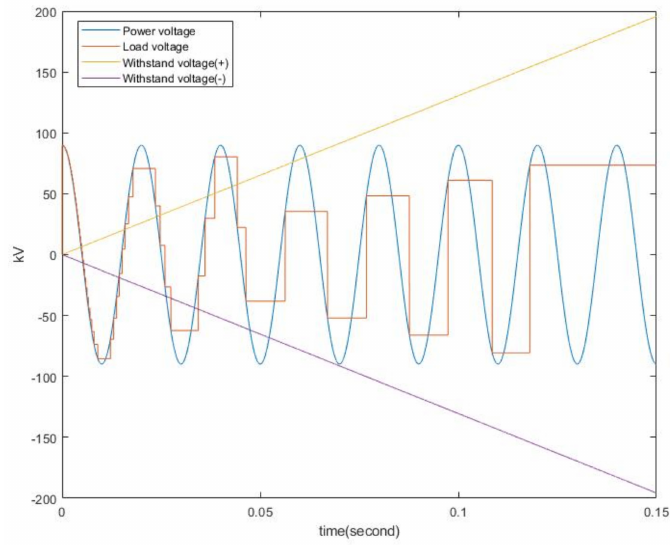
Figure 4. Power supply voltage, load side residual voltage, and breakdown voltage during the opening process of the disconnector switch.